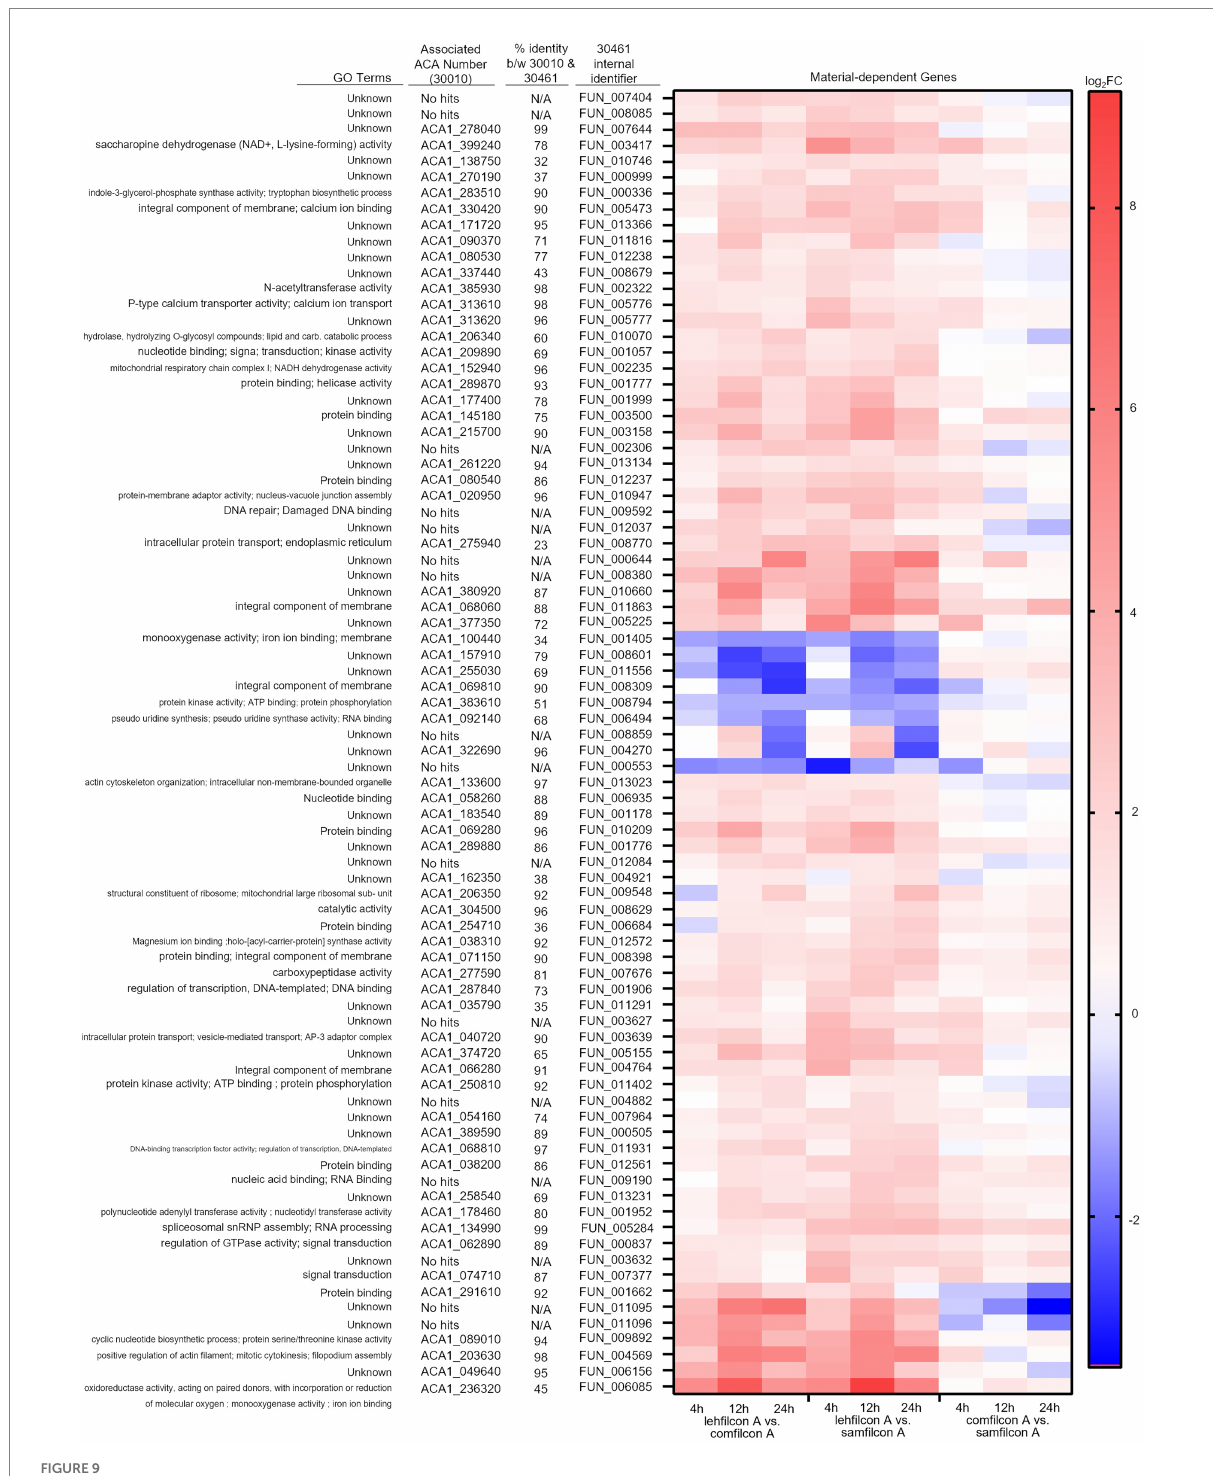
FIGURE 9 Genomic analysis of Acanthamoeba polyphaga (ATCC 30461) on three different contact lens materials at hours 4, 12, and 24. Eighty two genes were found to be significantly differentially regulated in at least two consecutive time points; p < 0.05, n = 6 per group. Genes were clustered according to gene expression pattern with those depicted falling into a predominantly contact lens material-dependent expression pattern. Heat maps display the kinetics of log2 fold change in expression on lehfilcon A relative to comfilcon A (left), lehfilcon A relative to samfilcon A (middle), and comfilcon A relative to samfilcon A (right). Genes are described according to locus identifier, closest identified homologue in ATCC 30010, and GO terms associated with ATCC 30010 protein according to